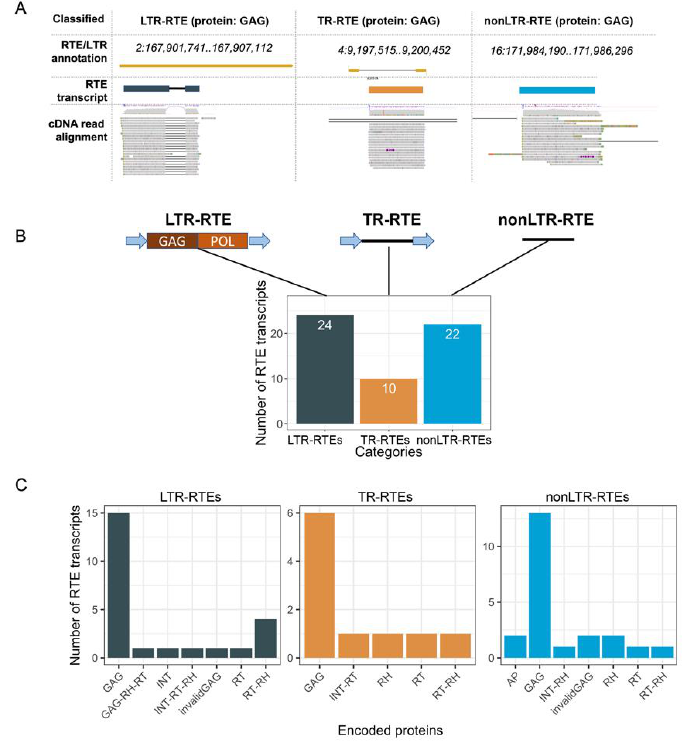
Figure 3. Classification of RTE transcripts into three categories. ( A ) Genome browser snapshots of RTE transcript loci from three categories with the ONT read alignment and LTR-RTE annotation. ( B ) Schematic representation of the structure of the three categories of RTE loci and the number of transcripts for each category. ( C ) Number of RTE transcripts carrying ORFs for different proteins. Thus, structural and protein analysis revealed three categories of loci from which RTE-related transcripts are expressed: LTR-RTEs, TR-RTEs, and nonLTR-RTEs. Among